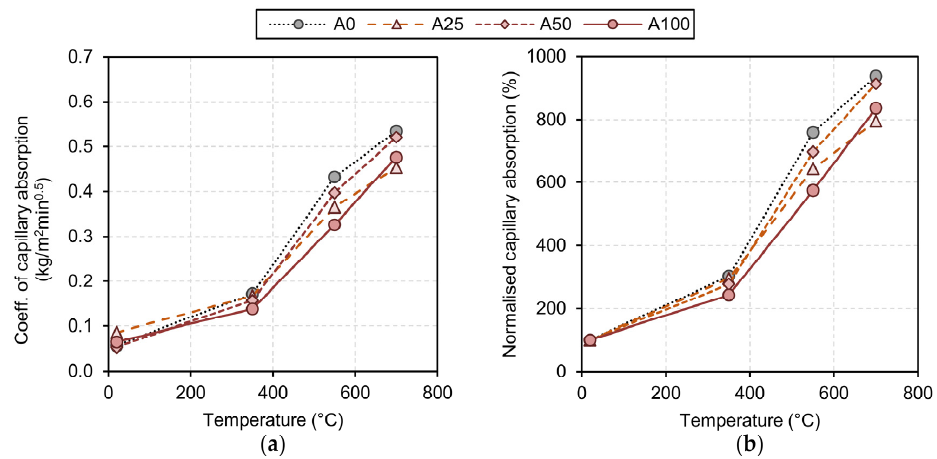
Figure 6. Evolution of the capillary water absorption with temperature. ( a ) Coe ff . of capillary absorption ( b ) Normalised capillary absorption.